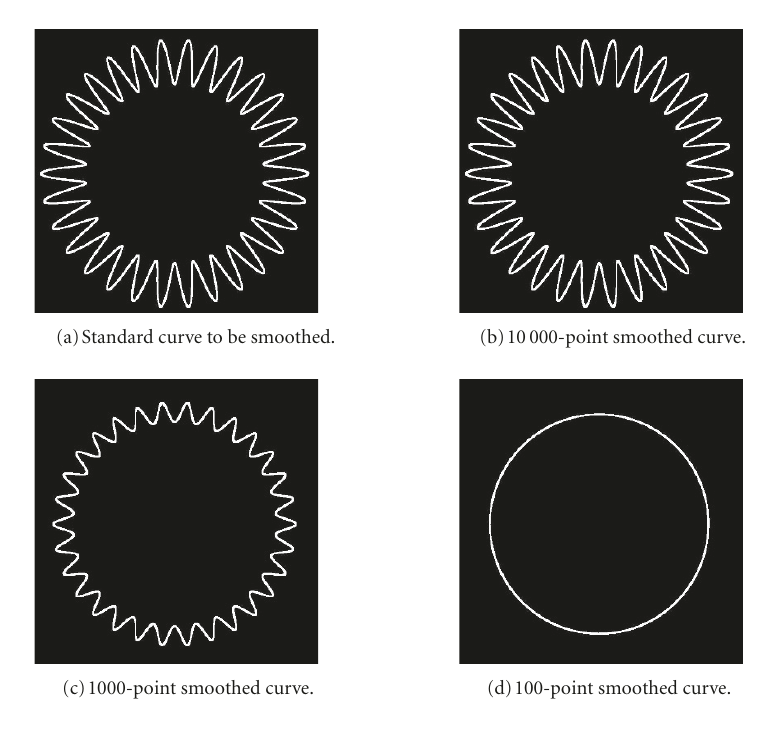
Figure 9: Illustration of the influence of sampling over the λ value. Each curve is smoothed by the same smoothing B-spline filter with λ = 1000.